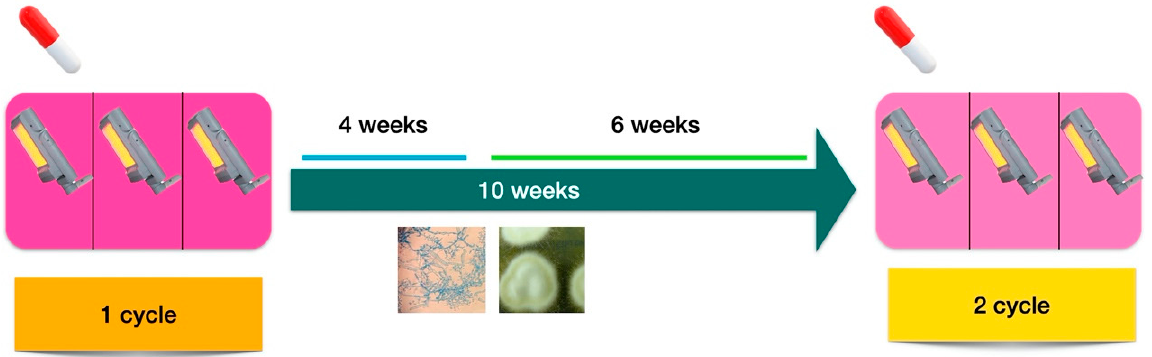
Figure 2. Protocol for photodynamic therapy combined with oral terbinafine for the treatment of dermatophyte onychomycoses. Three sessions separated by 1 or 2 weeks of MAL-PDT combined with terbinafine (250 mg/day) for 1 month, followed by another cycle of 3 sessions of MAL-PDT if necessary (i.e., in cases of persistent positive culture